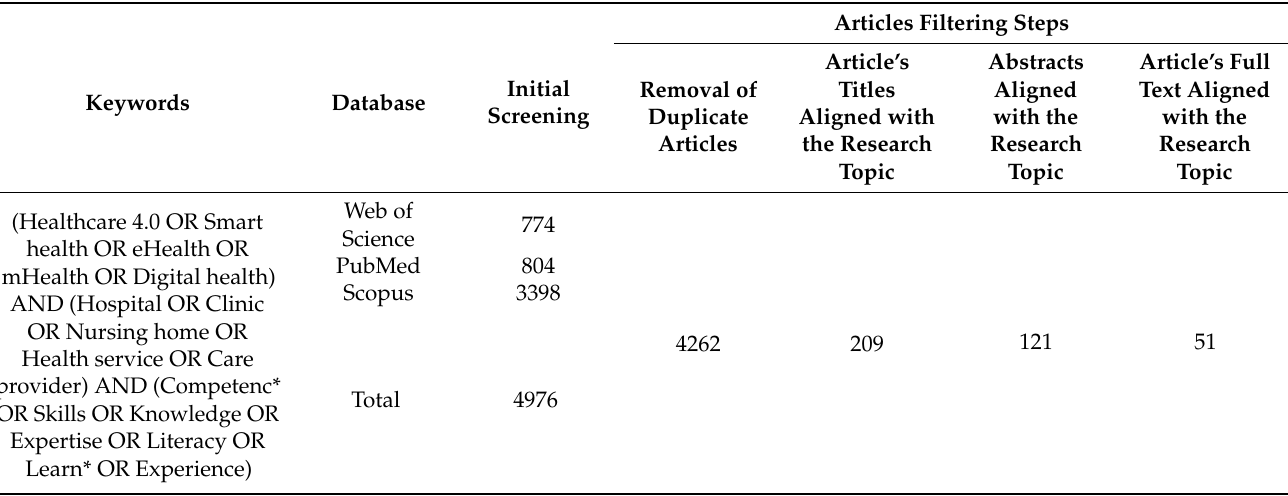
Table 3. Filtration and selection of